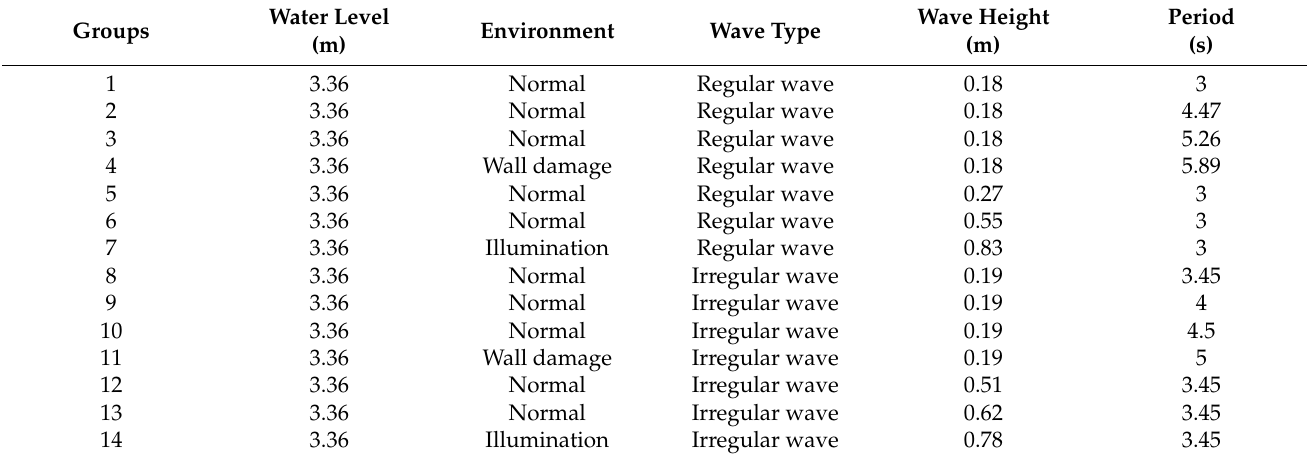
Table 1. Experimental working condition parameter table.